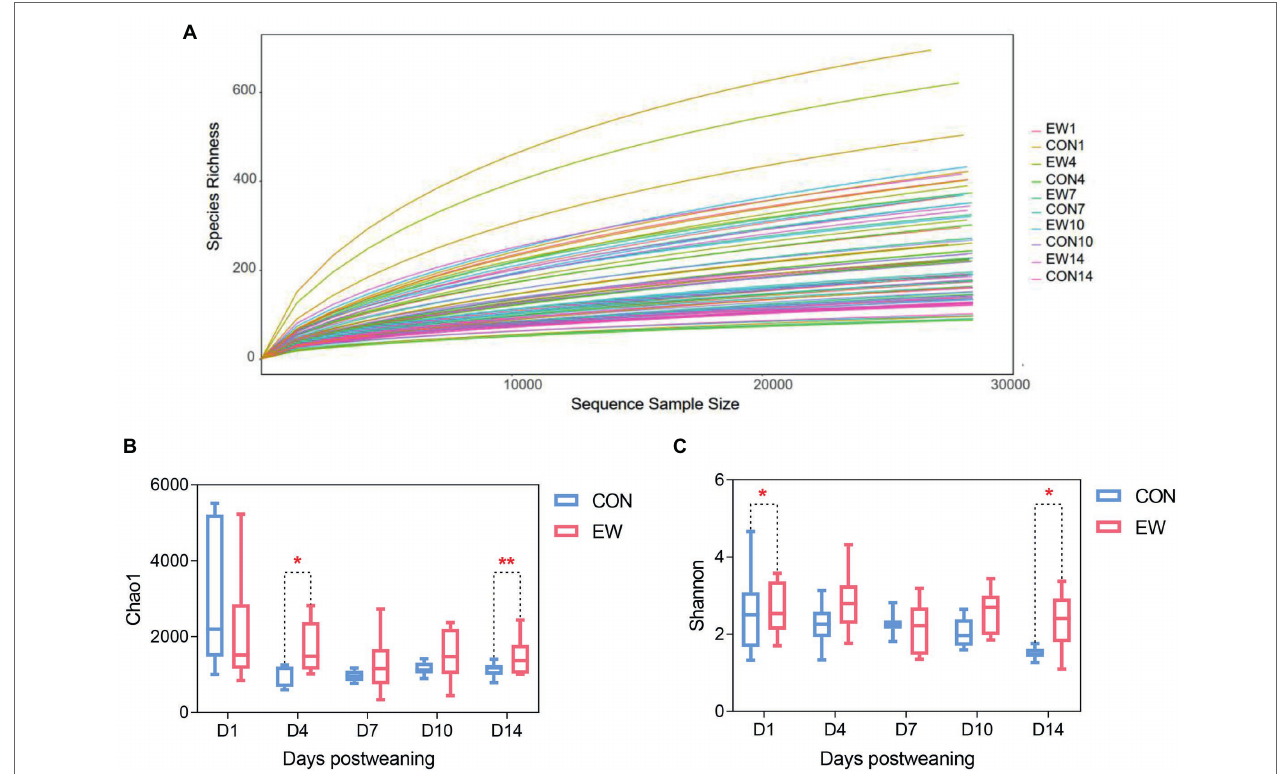
FIGURE 2 | Effects of early weaning on α -diversity of ileal microbiota in squabs. D1, D4, D7, D10, and D14 means 1, 4, 7, 10, and 14 days postweaning, respectively. (A) Rarefaction curves; (B) richness index: Chao 1; (C) diversity index: Shannon. Values are means with their standard errors of eight squabs. * and ** mean p < 0.05 and p < 0.01, respectively, within each time points postweaning. CON, control group; EW, early weaning